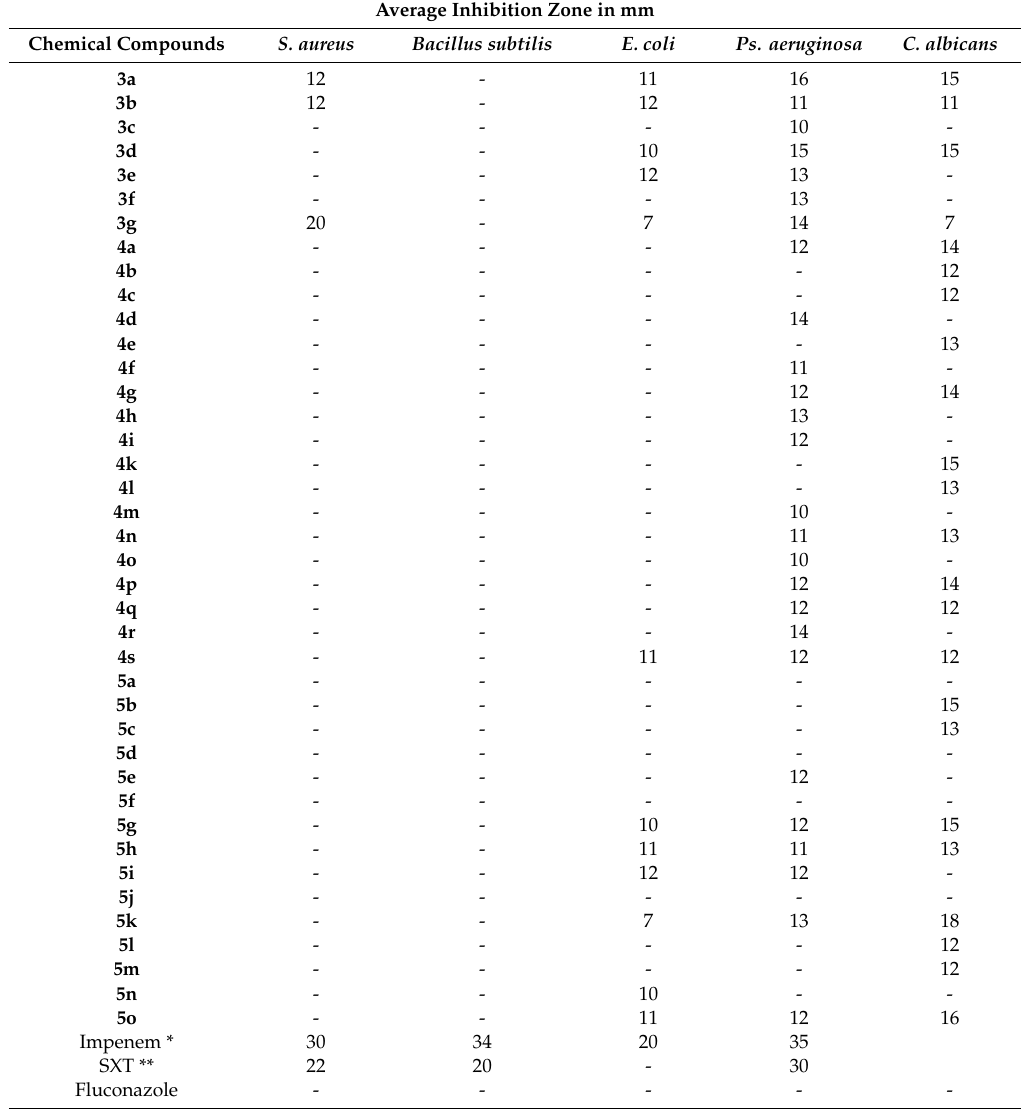
Table 1. Antimicrobial activity (zones of inhibition, mm) compared with several standard antimicrobial